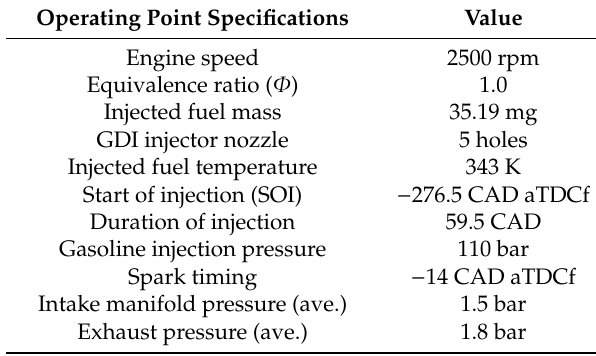
Table 2. Operating point